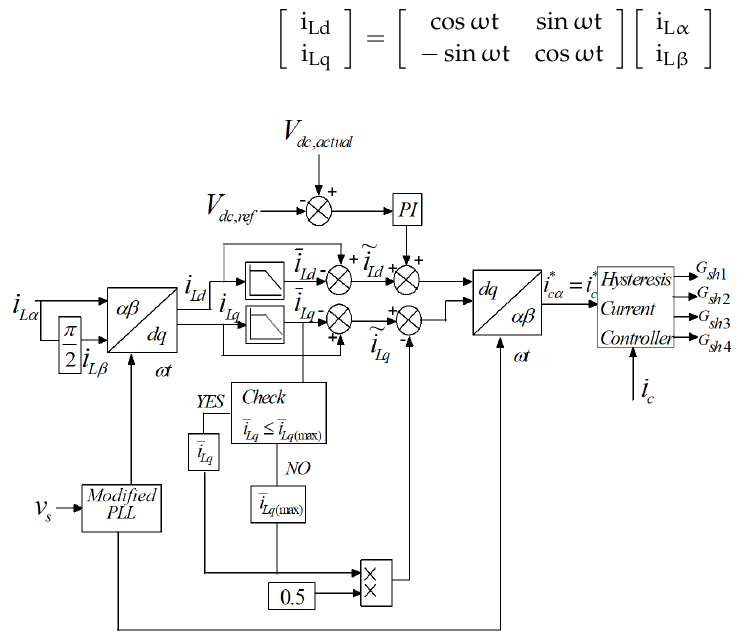
Figure 2. SRF method ‐ based shunt